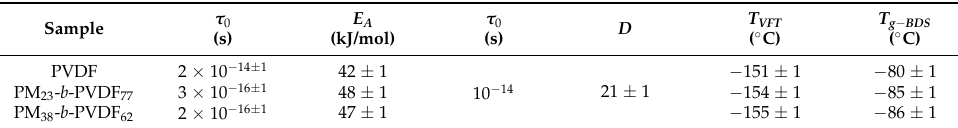
Table 4. Arrhenius fit results for PVDF and its copolymers with PM.